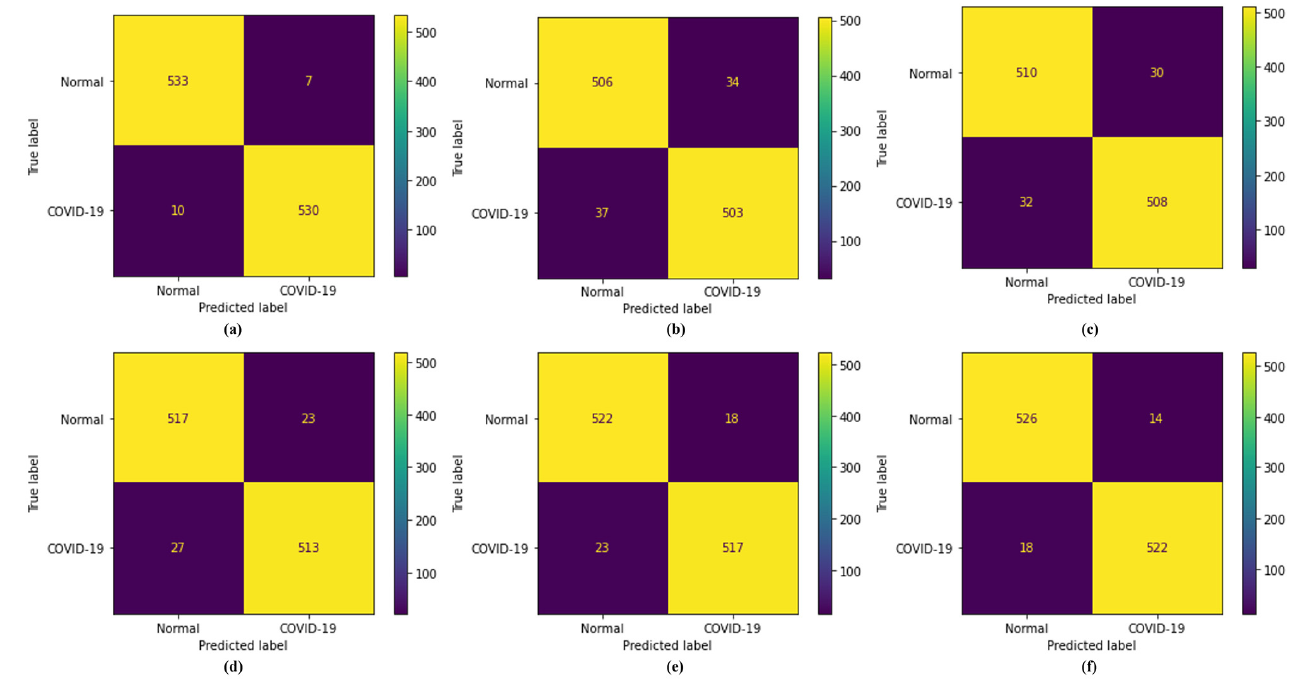
Figure 5 . Confusion matrices; ( a ) proposed model, ( b ) VGG-16, ( c ) VGG-19, ( d ) ResNet-101, ( e ) DenseNet-169, and ( f ) DenseNet-201.